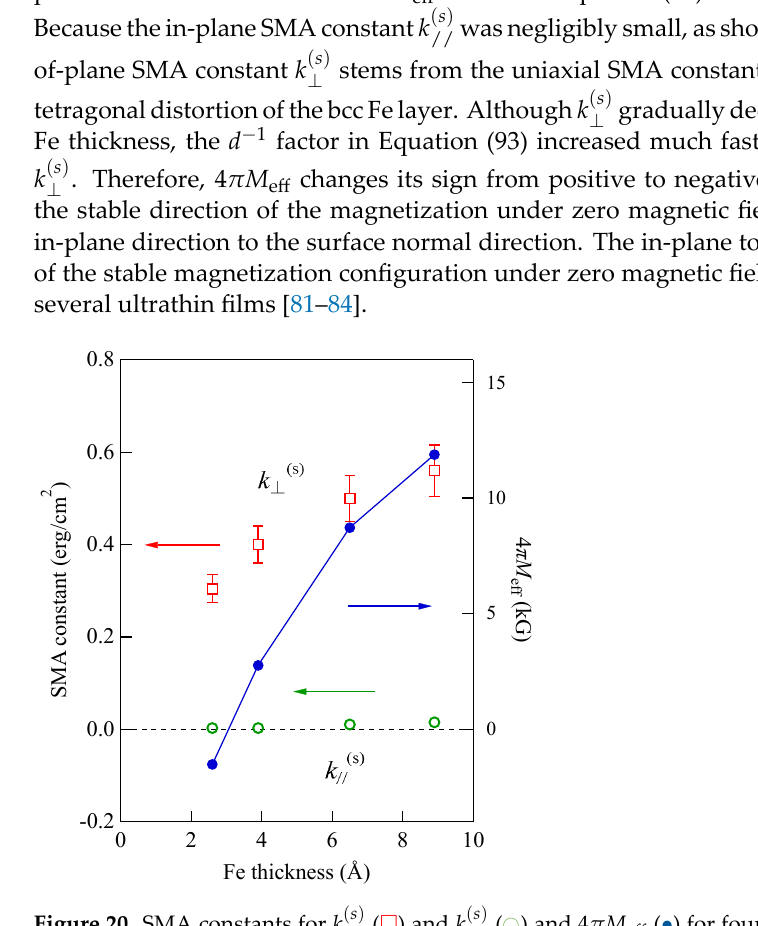
Figure 20. SMA constants for k The solid lines are just for eye. [79]